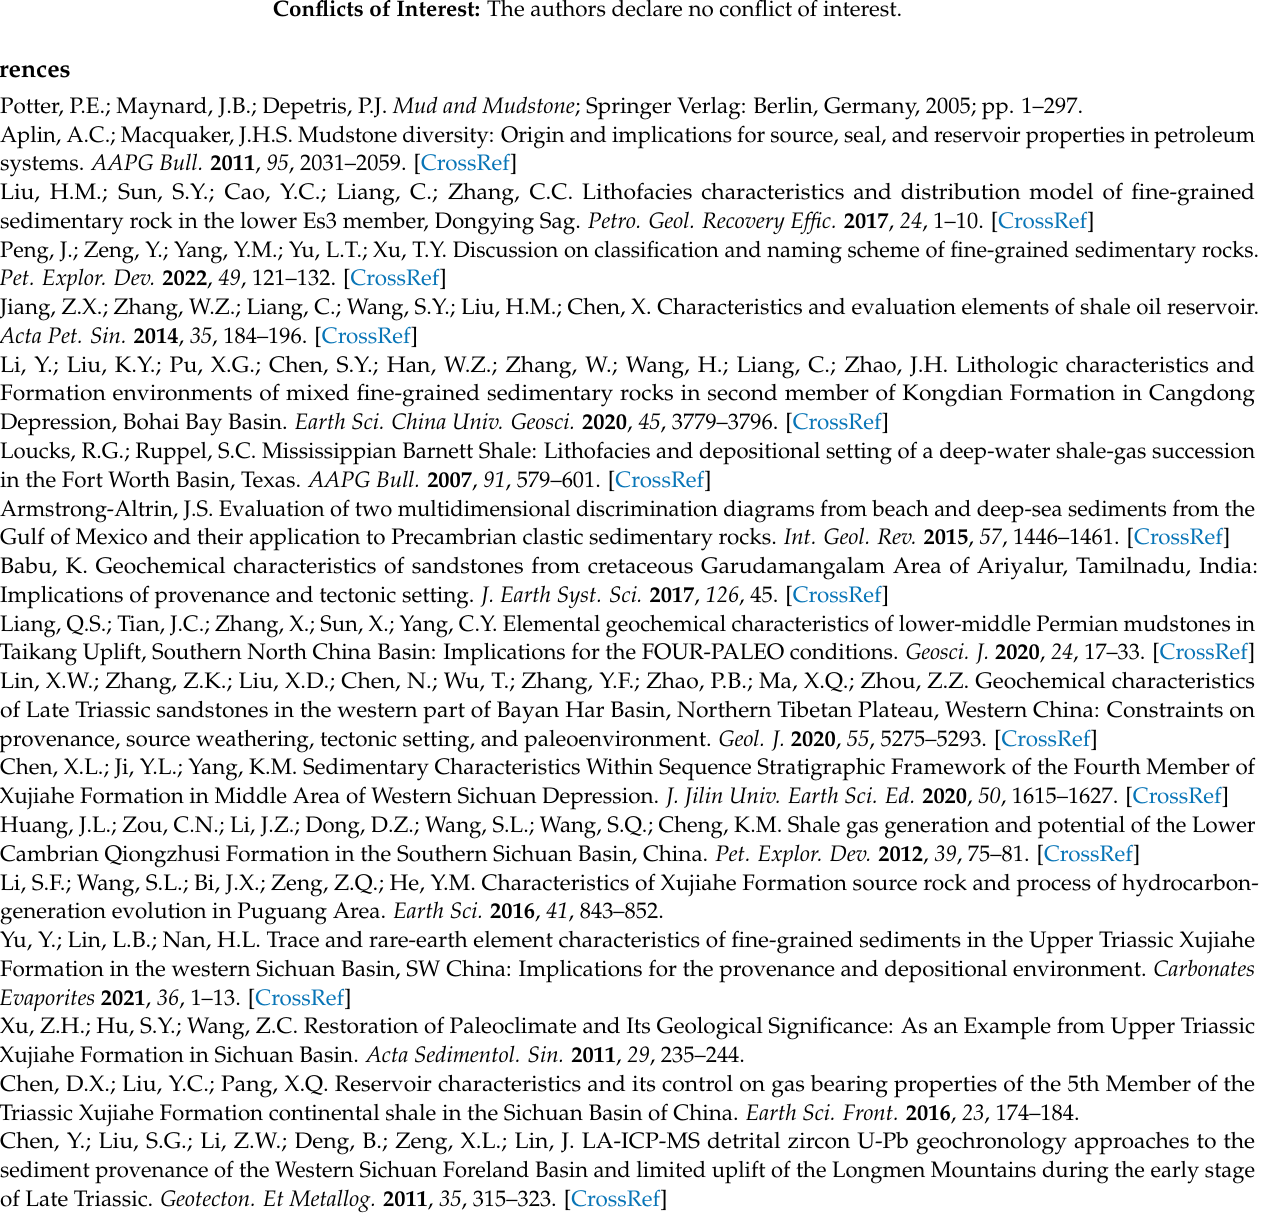
Table S3: Trace elements and REEs; Table S4: Calculated